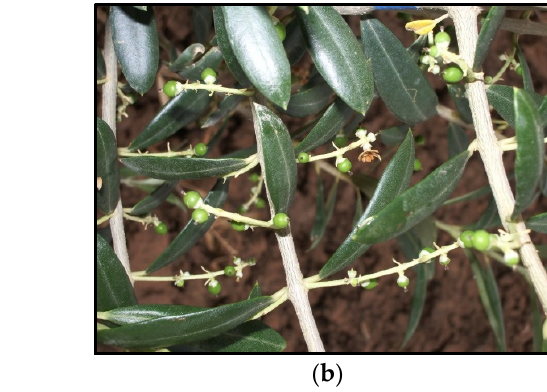
Figure 2. Inflorescences are composed of several flowers during bloom ( a ) and after fruit set and the first fruit falling at the beginning of summer ( b ). Table 7. The number of flowers per cm of branch and fruit setting rate (%) during three tested years. (MRDI: moderate regulated deficit irrigation; SRDI: severe regulated deficit irrigation; CDI: continuous deficit irrigation). Different letters showed significant differences ( p ≤ 0.05) among treatments for the same year according to Duncan’s test.